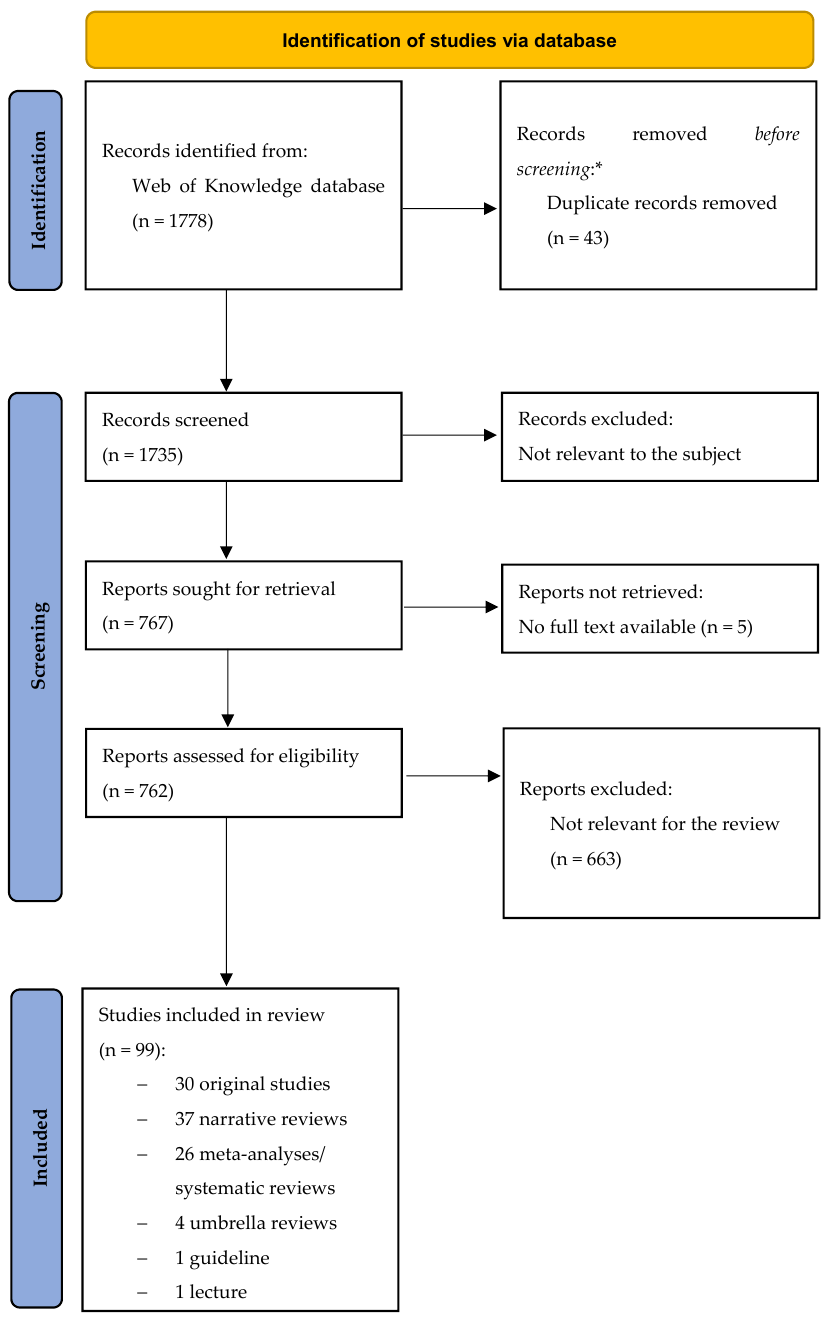
Figure 1. PRISMA flow-chart